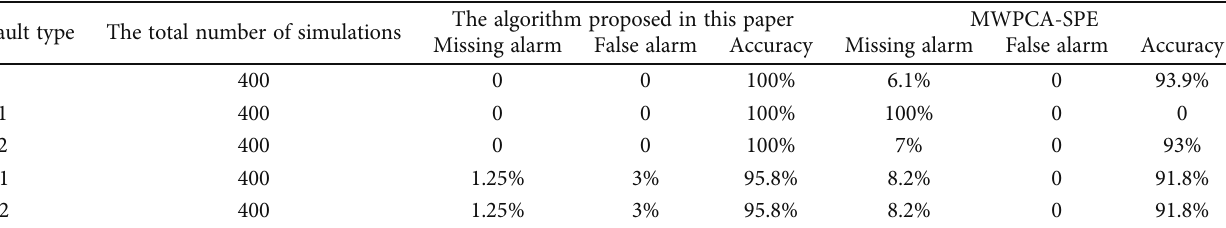
Figure 14: Drift failure with inconsistent trend between two sensors. Table 3: Statistics of simulation